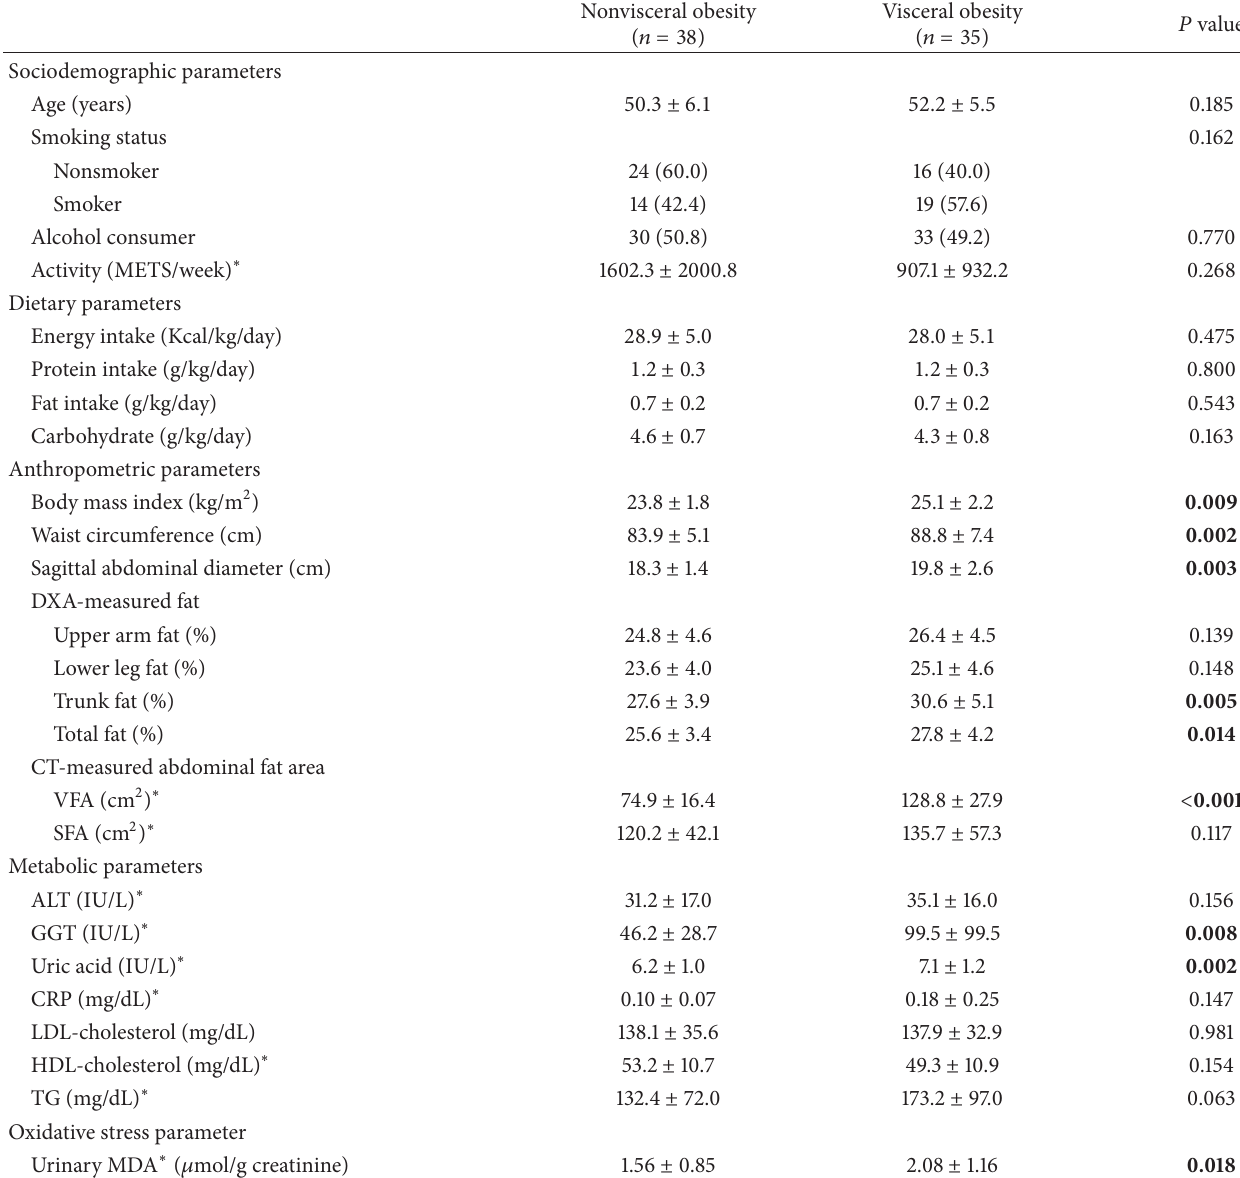
Table 2: Characteristics of patients in the two study